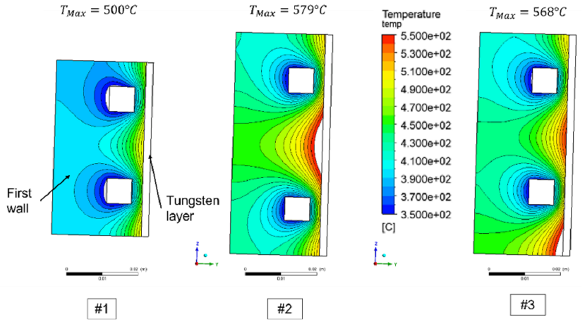
Figure 5. Temperature distribution for the optimization of FW refrigeration.